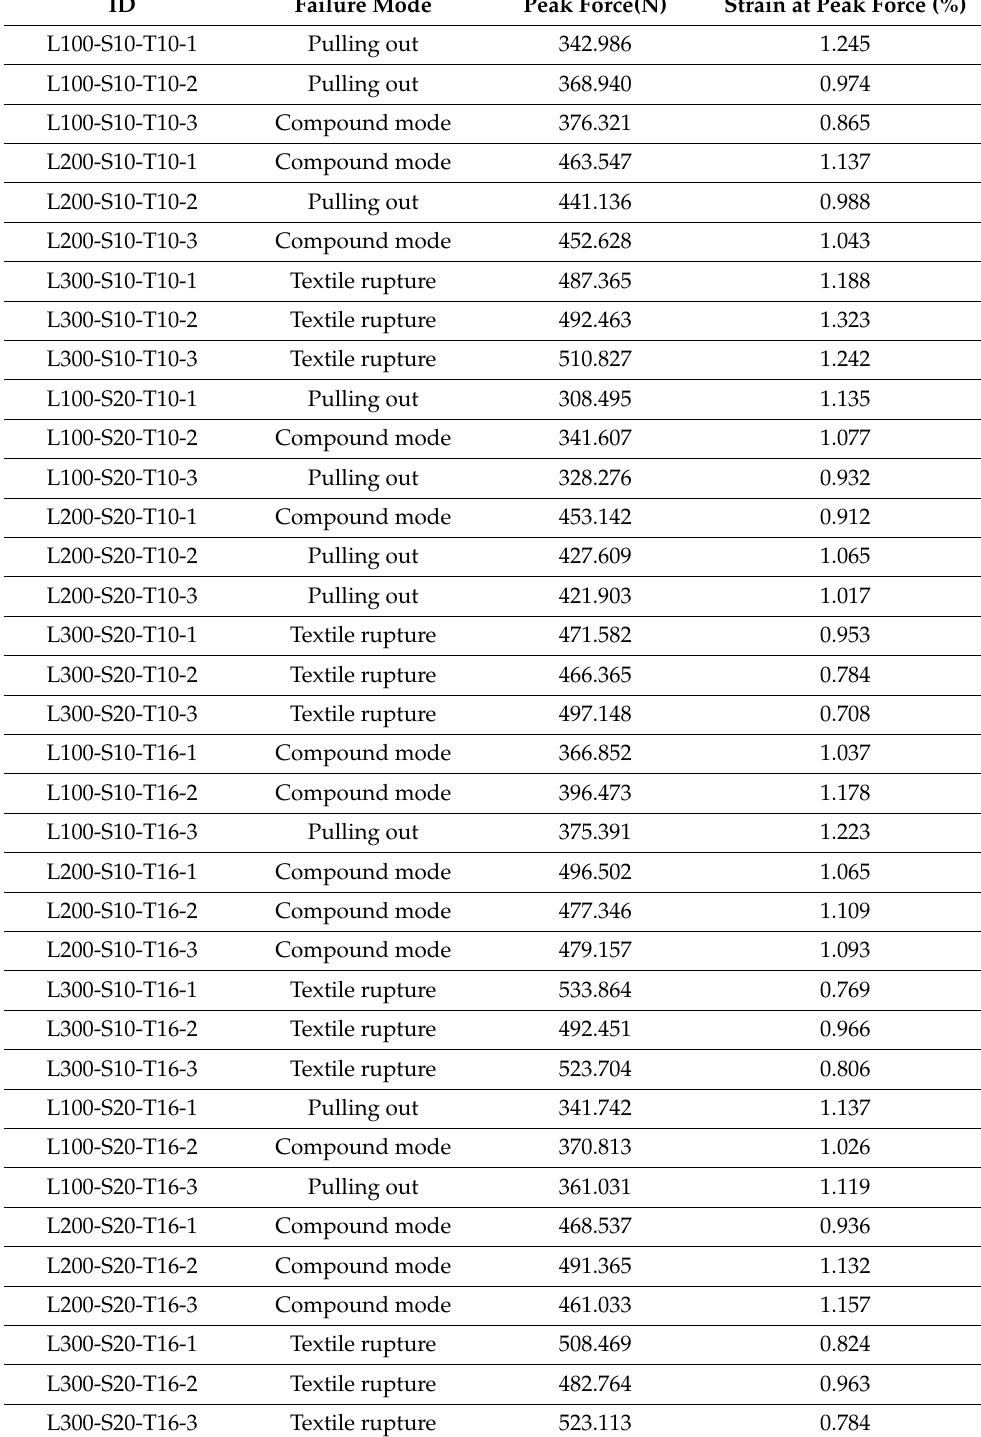
Table 2. Summary of the results for all the test